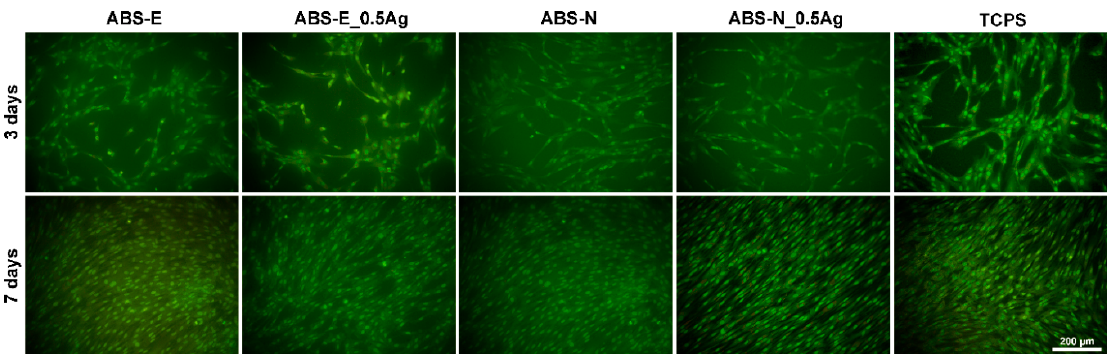
Figure 8. Fluorescence microscope images of Saos-2 cells in direct contact with the tested materials. Magnification 20 × .